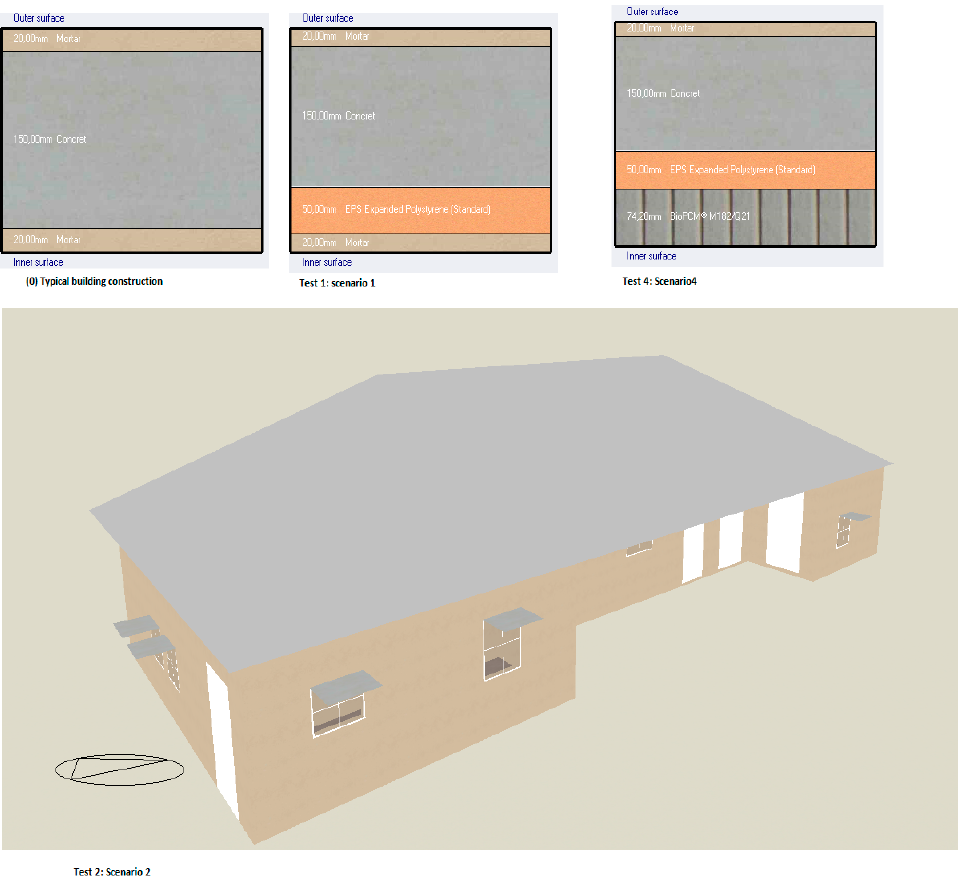
Figure 4. Typical uninsulated (0) and different scenarios.